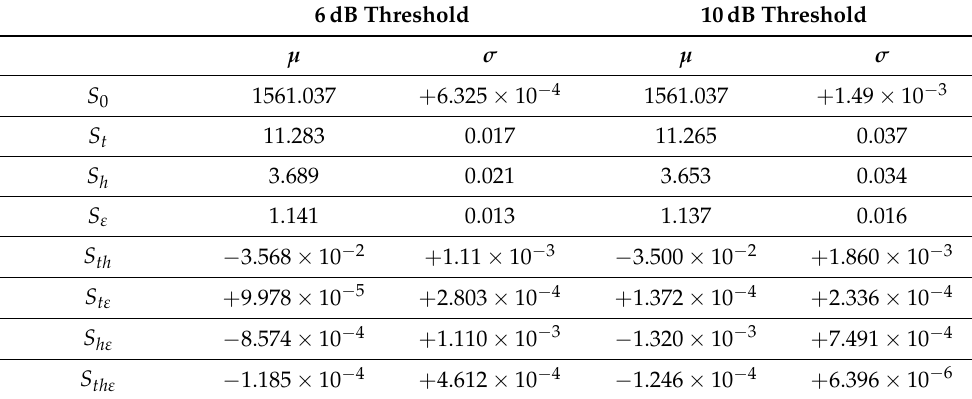
Table 9. Mean ( µ ) and standard deviation ( σ ) over the six peak detection algorithms of sensitivities calculated for 6 and 10dB thresholds.